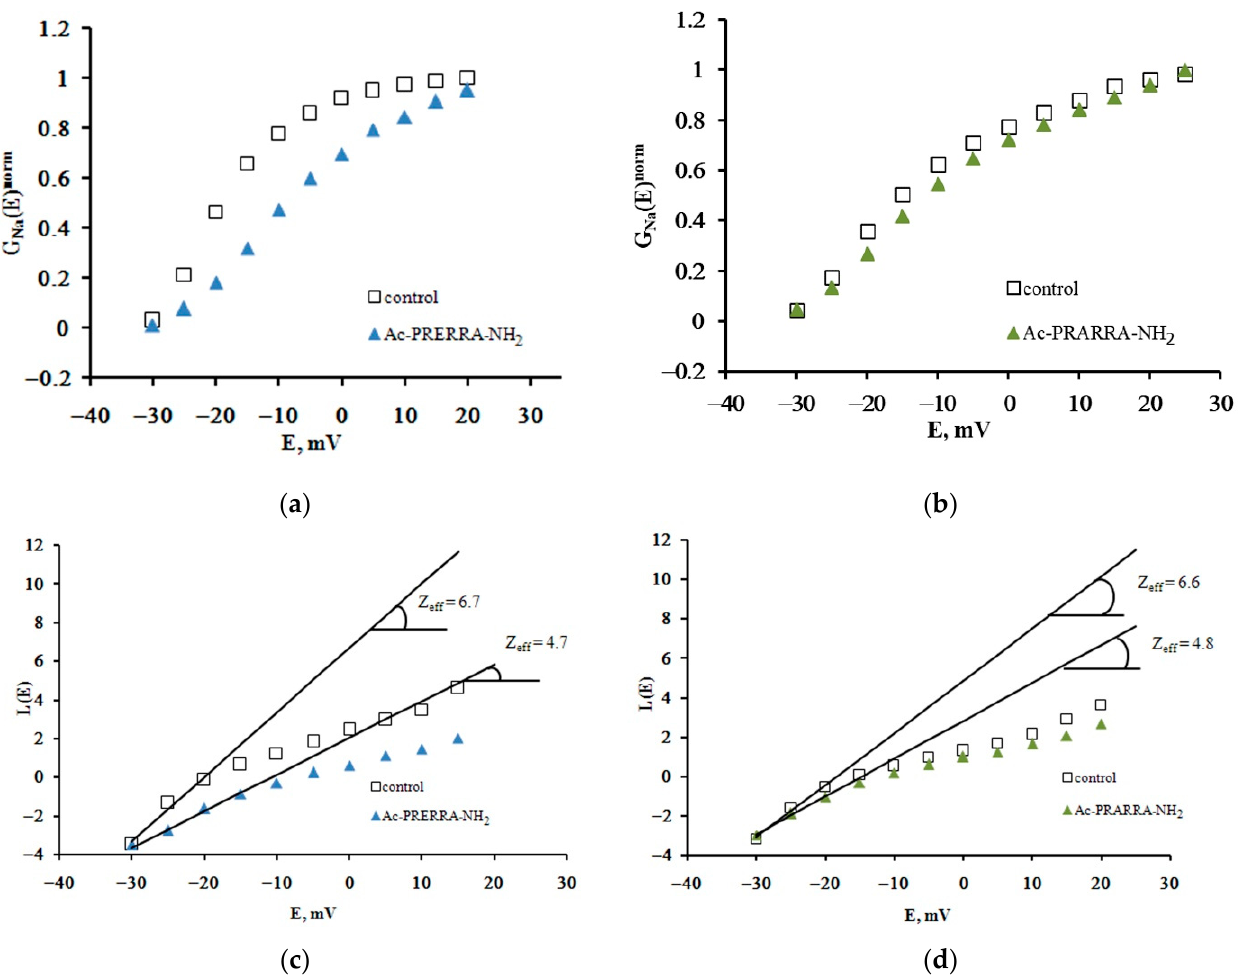
Figure 2. Ac-PRERRA-NH 2 and Ac-PRARRA-NH 2 modulate the voltage sensitivity of the Na V 1.8 channel activation gating system. The voltage dependence of the Na V 1.8 channel chord conductance, G Na (E) norm , in the control experiment and after the application of Ac-PRERRA-NH 2 ( a ) and Ac- PRARRA-NH 2 ( b ). Evaluation of Z eff from the logarithmic voltage sensitivity function L(E) after the application of Ac-PRERRA-NH 2 ( c ) and Ac-PRARRA-NH 2 ( d ).